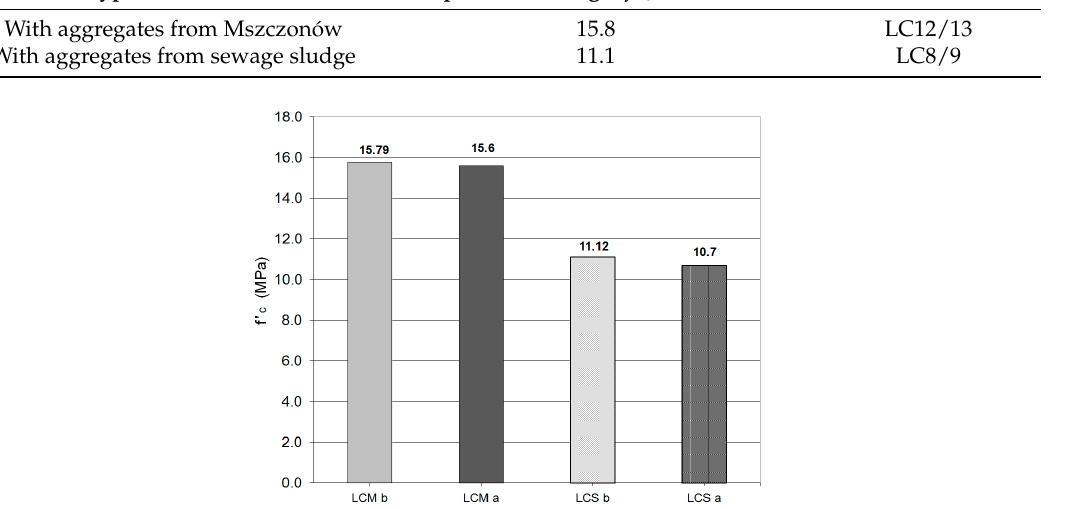
Figure 6. Compressive strength of samples examined for frost resistance-comparative samples and frozen samples: LCM b—lightweight concrete “Mszczonów” before freezing; LCM a—lightweight